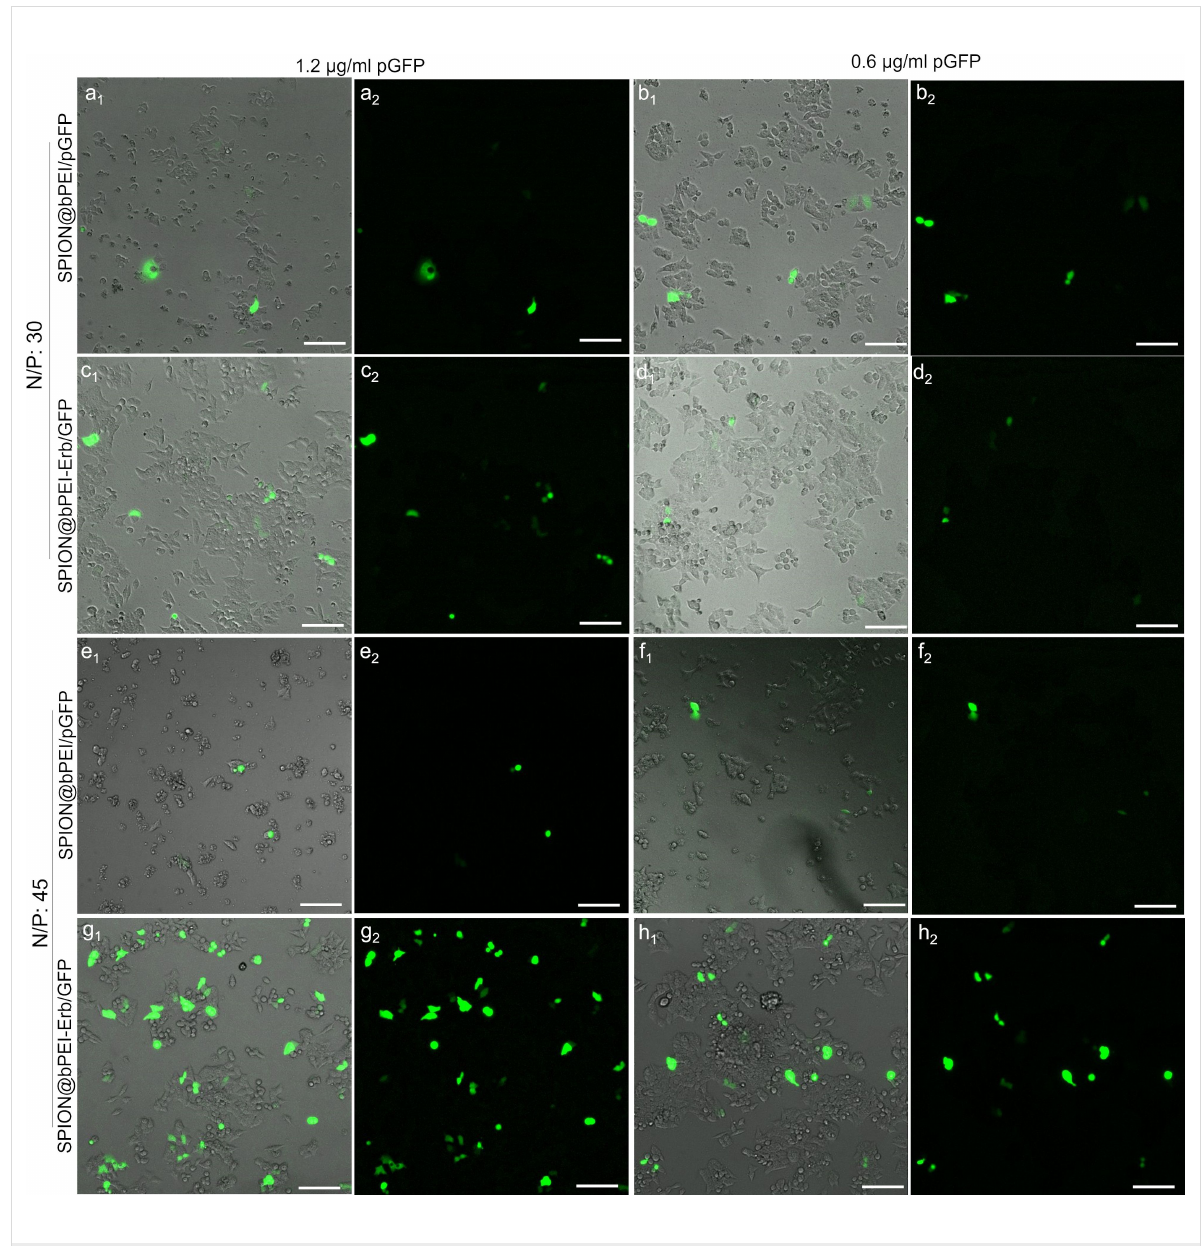
Figure 6: Fluorescence microscopy images of HCT116 cells transfected with SPION@bPEI/pGFP or SPION@bPEI-Erb/pGFP at an N/P ratio of 30 (5a–d) with a) 1.2 µg/mL pDNA loaded on 12.8 µg/mL SPION@bPEI, b) 0.6 µg/mL pDNA loaded on 6.4 µg/mL SPION@bPEI, c) 1.2 µg/mL pDNA loaded on 13.8 µg/mL SPION@bPEI-Erb, d) 0.6 µg/mL pDNA loaded on 6.9 µg/mL SPION@bPEI-Erb. Fluorescence microscopy images of HCT116 cells transfected with SPION@bPEI/pGFP or SPION@bPEI-Erb/pGFP at an N/P ratio of 45 (5e–h) with e) 1.2 µg/mL pDNA loaded on 19.2 µg/mL SPION@bPEI, f) 0.6 µg/mL pDNA loaded on 9.6 µg/mL SPION@bPEI, g) 1.2 µg/mL pDNA loaded on 20.7 µg/mL SPION@bPEI-Erb, h) 0.6 µg/mL pDNA loaded on 10.35 µg/mL SPION@bPEI-Erb. All images were taken 48 h after transfection. Images with subscription 1 are merges images, and images with subscription 2 are green fluorescence microscopy images. Scale bar = 100